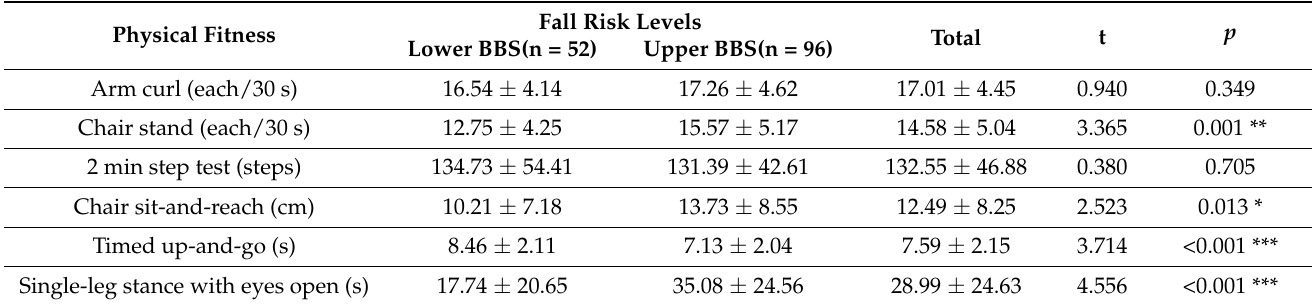
Table 3. Comparison of physical fitness according to fall risk level (BBS).